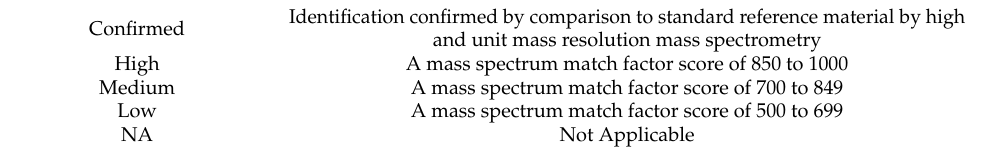
Table 4. Confidence Levels of Compounds Identified by GC–MS